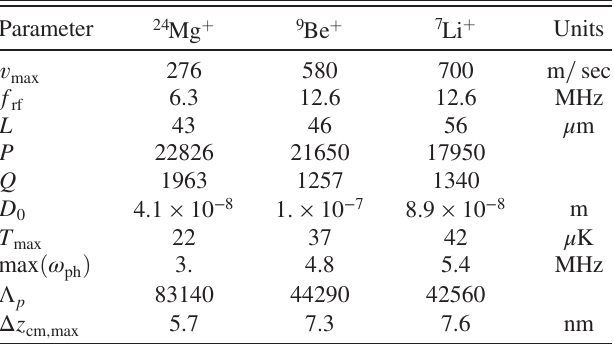
TABLE I. Parameters needed to create an ion Coulomb crystal in a circular rf quadrupole for three different types of ions, where we assume cooling has achieved δ p=p ¼ 10 − 7 , all with a C ¼ 1 m